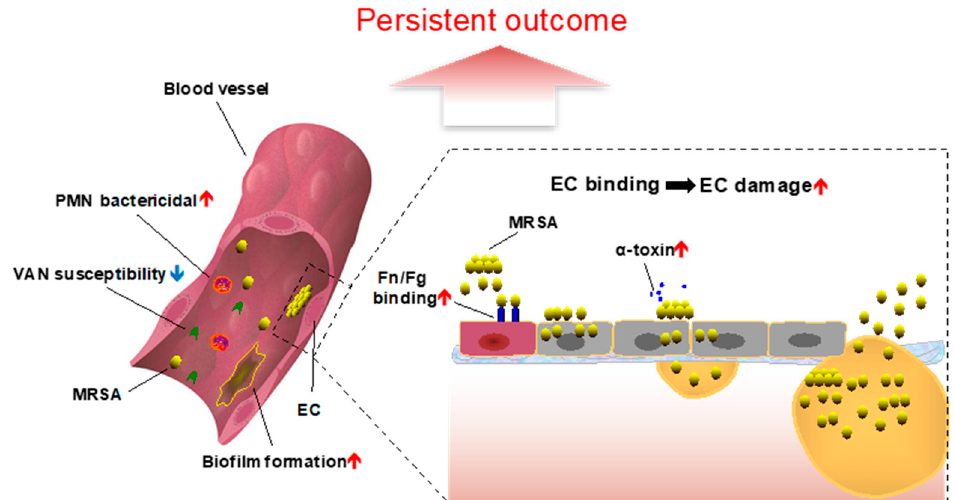
Figure 1. Overview of persistent bacteremia in the context of endovascular infection due to methicillin-resistant Staphylococcus aureus [6]. EC, endothelial cell; Fn, fibronectin; Fg, fibrinogen; PMN, neutrophils; VAN,